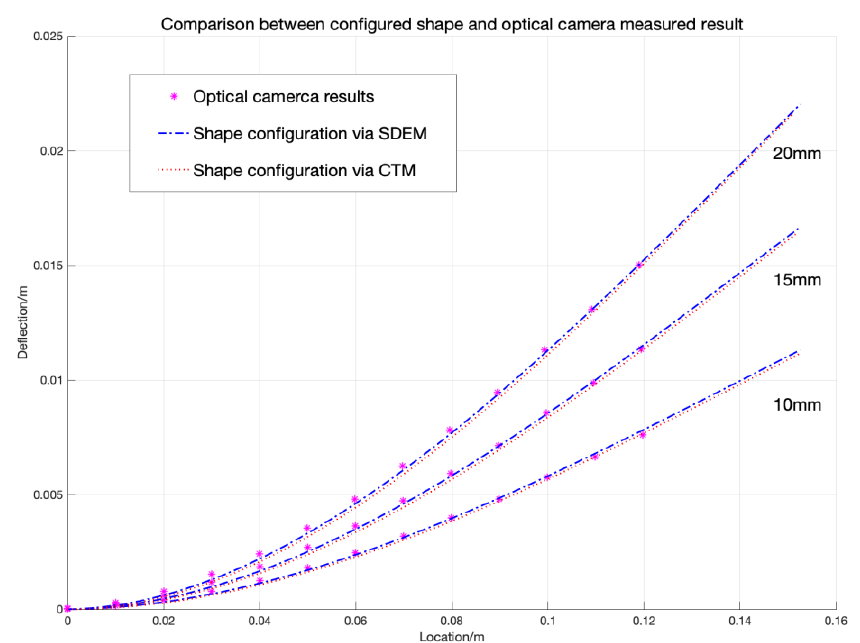
Figure 22. Experimental and simulated results.